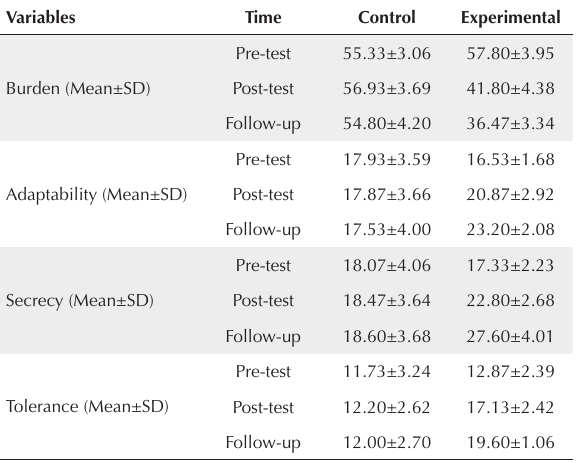
Table 3. Descriptive indices of dependent variables in experimental and control groups Variables